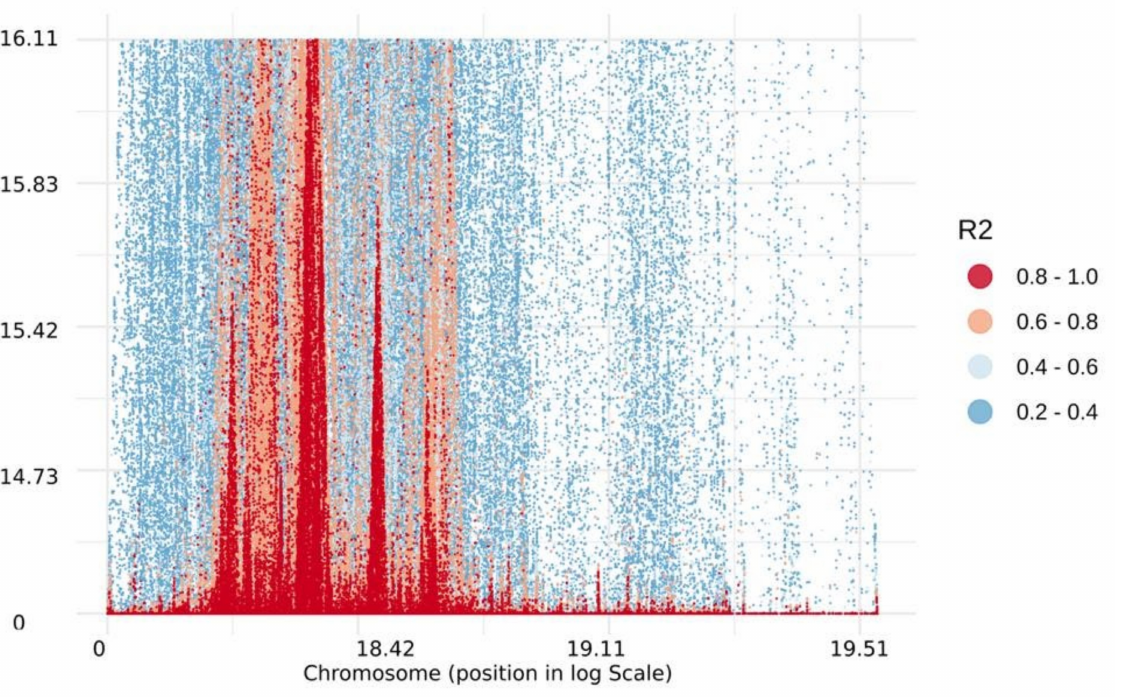
Figure 7. Distribution of linkage disequilibrium between individual SNPs pairs across the genome of 384 inbred lines genotyped with 60,277 SNPs. The horizontal and vertical axis representing the SNPs pairs and legend insert inside depicts the various classes of LD values ranging from 0.2 to